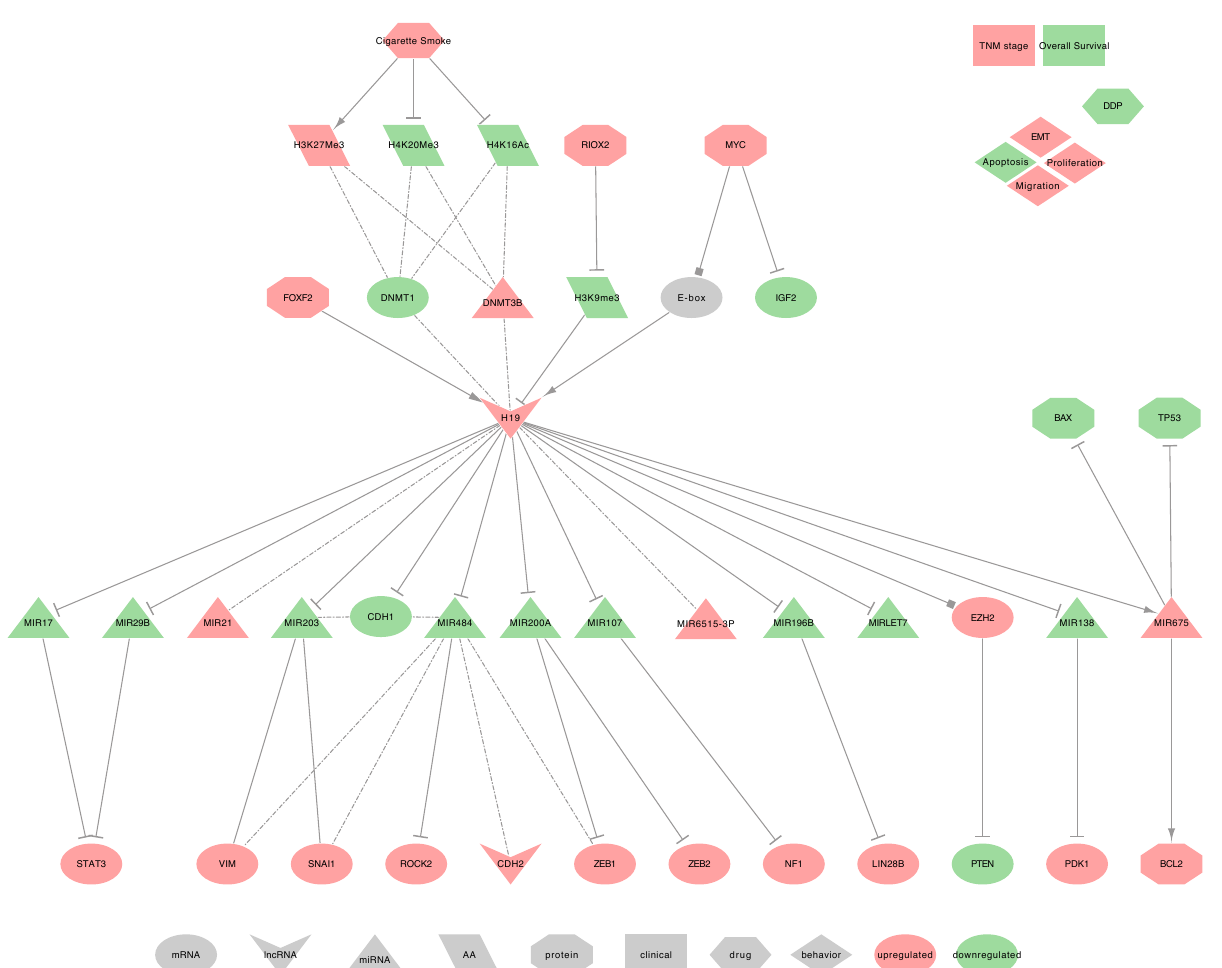
Figure 5. H19 in lung cancers: A network of lncRNA-miRNA-Protein interactions. Upregulated molecules are in green. Downregulated molecules are in red. Shape definitions are in grey. Gray arrows target the activated molecules. T-ended lines target the inhibited molecules. Square-ended lines represent a binding between molecules. Dashed-dot lines represent an association with unknown